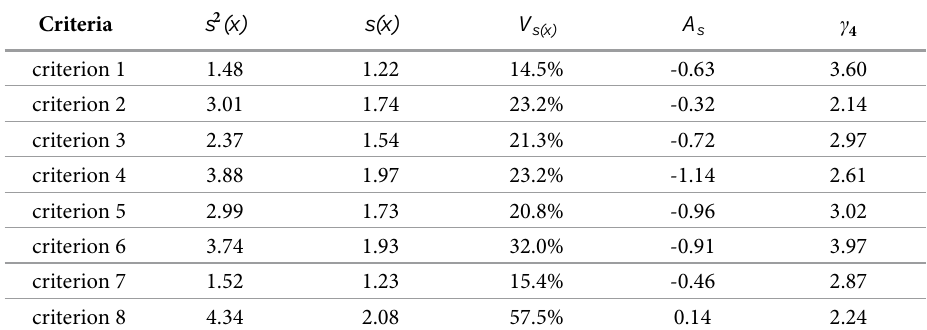
Table 2. Values of classical descriptive statistical measure calculated for particular criteria Criteria s 2 (x)